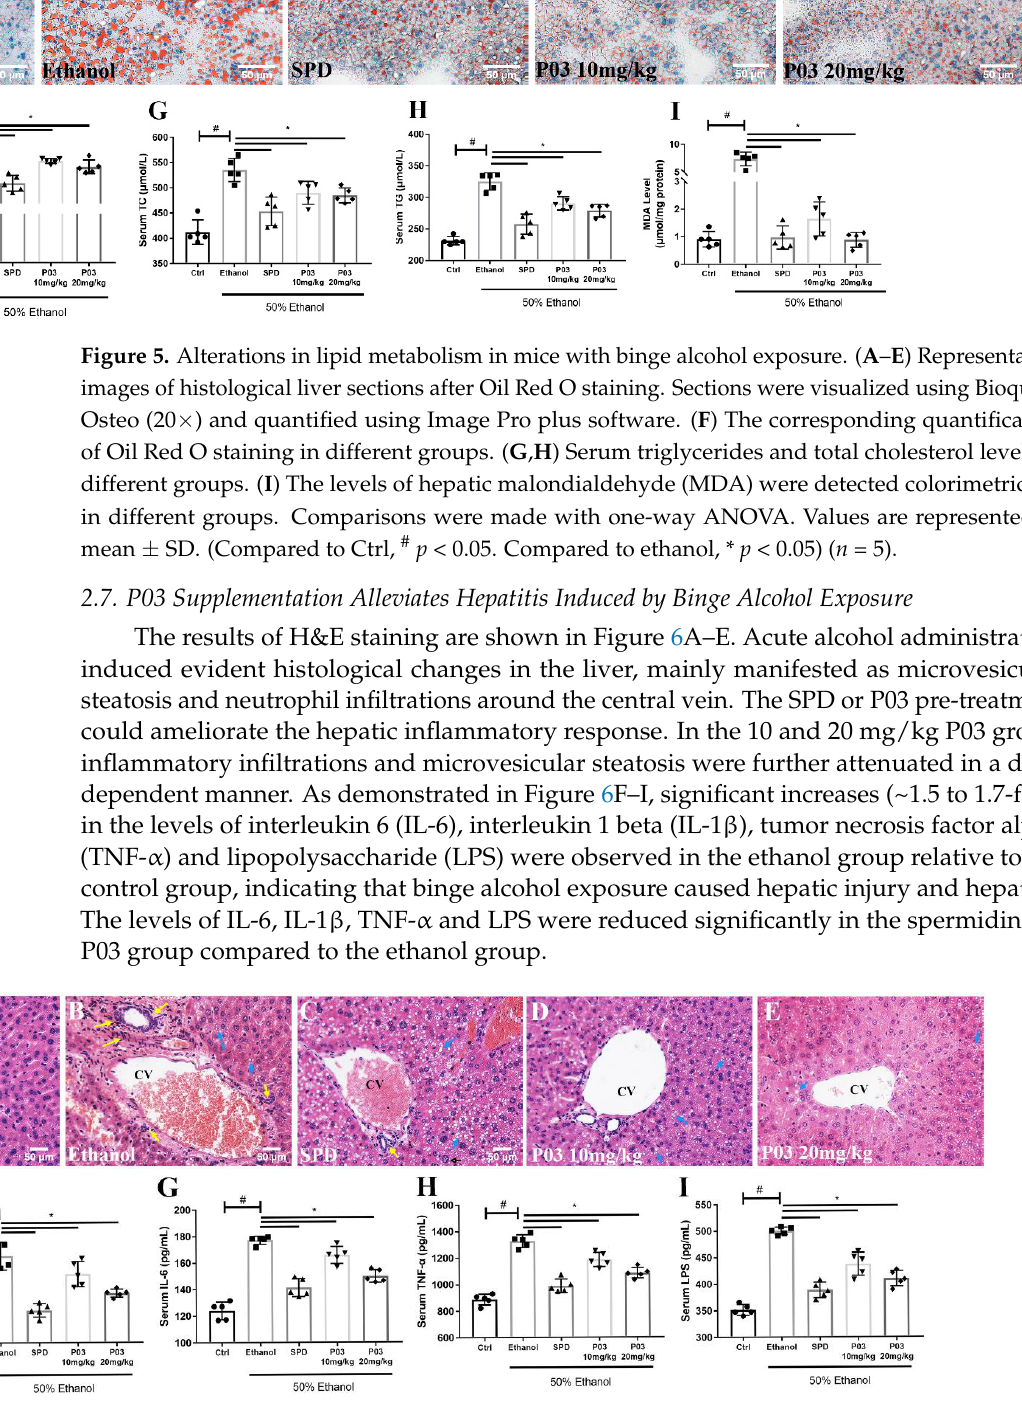
Figure 6. Anti-inflammatory effects of P03 in mice with binge alcohol exposure. ( A – E ) Representative images of histological liver sections after H&E staining. Sections were visualized using Bioquant Osteo (20×). Yellow arrows represent neutrophil infiltration surrounding the central vein (CV); blue arrows represent microvesicular steatosis. Scale bar = 50 μ M. ( F – I ) Serum levels of inflammatory cytokines and LPS in different groups. Comparisons were made with one-way ANOVA. Values are represented as mean ± SD. (Compared to Ctrl, # p < 0.05. Compared to ethanol, * p < 0.05) ( n = 5). The results of the immunoblots for the protein expression of nuclear factor kappa B (NF- κB) in the cytoplasm and the nucleus are illustrated in Figure 7A – D. Compared to the control group, acute alcohol exposure led to a significant increase in NF- κB translocation, which was significantly inhibited in the SPD and 20 mg/kg P03 group. Meanwhile, com- pared to the ethanol group, the 10 mg/kg P03 supplementation had few effects on NF- κB translocation. Figure 7. Immunoblots of nuclear and cytoplasmic NF- κB. ( A ) Western blot analysis of NF- κB i n different groups. ( B – D ) Relative protein levels of NF- κB in nucleus and cytoplasm in each group. Densitometric quantification of nuclear and cytoplasmic NF- κB were performed and normalized to β -actin levels (for the cytosolic factions) or Lamin B1 (for the nuclear fractions). The values are rep- resented as mean ± SD and plotted as fold-change. (Compared to Ctrl, # p < 0.05. Compared to etha- nol, * p < 0.05). 2.8. P03 Supplementation Prevents Apoptosis of Hepatocytes Induced by Binge Alcohol Exposure To investigate cell apoptosis in the liver, B-cell lymphoma-2 (Bcl-2), Bcl-2-associated X (Bax), cytochrome C (Cyto-C), Caspase-3, and poly ADP-ribose polymerase (PARP) ex- pression were immunoblotted. As illustrated in Figure 8A – D, the Bcl-2/Bax ratio in the mice of the ethanol group was reduced two-fold compared to the control group. Com- pared to the ethanol group, the SPD and 20 mg/kg P03 group exhibited a slight increase in Bcl-2/Bax ratio, but the differences were insignificant. Meanwhile, the protein expres- sion of Cytochrome C, Caspase 3 and PARP in the ethanol group was significantly ele- vated by 117.8 ± 6.24, 121.8 ± 9.62 and 127 ± 6.97%, respectively, compared to the control